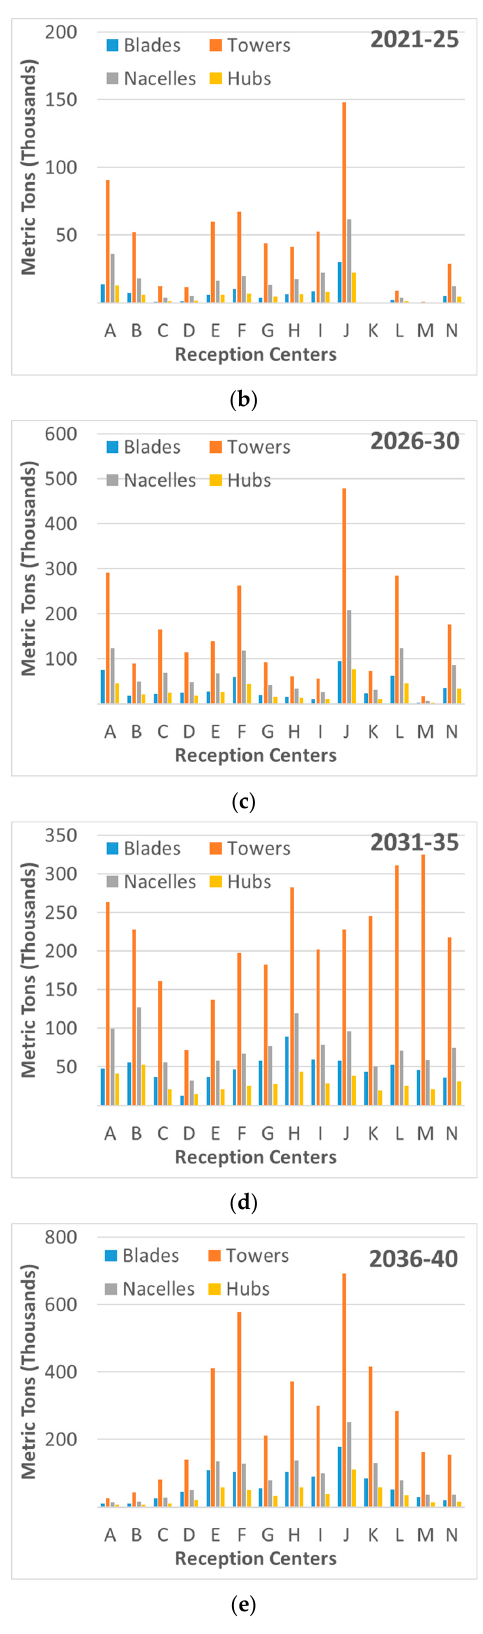
Figure 13. Expected volume per component for US—EoL centers over time considering decommissioning year: ( a ) before 2021, ( b ) 2021–2025, ( c ) 2026–2030, ( d ) 2031–2035, ( e )